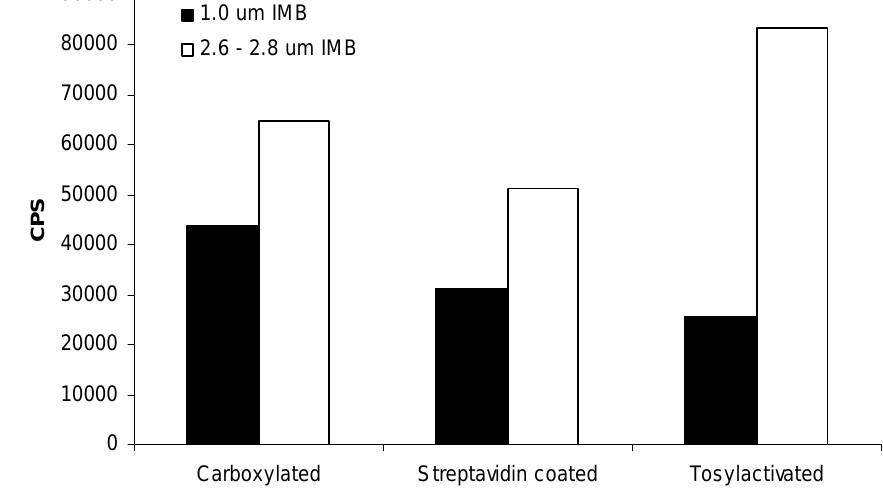
Figure 3. Comparison of IMB using 1×10 6 beads/20  L assay volume. Each IMB was diluted in PBS to contain 1×10 6 beads/20  L and tested for capture with 1×10 7 cells/mL E. coli O157:H7 strain B1409. The larger sized beads provided greater capture of bacteria than those of a smaller size. The average percent error among three independent experiments run in triplicate was